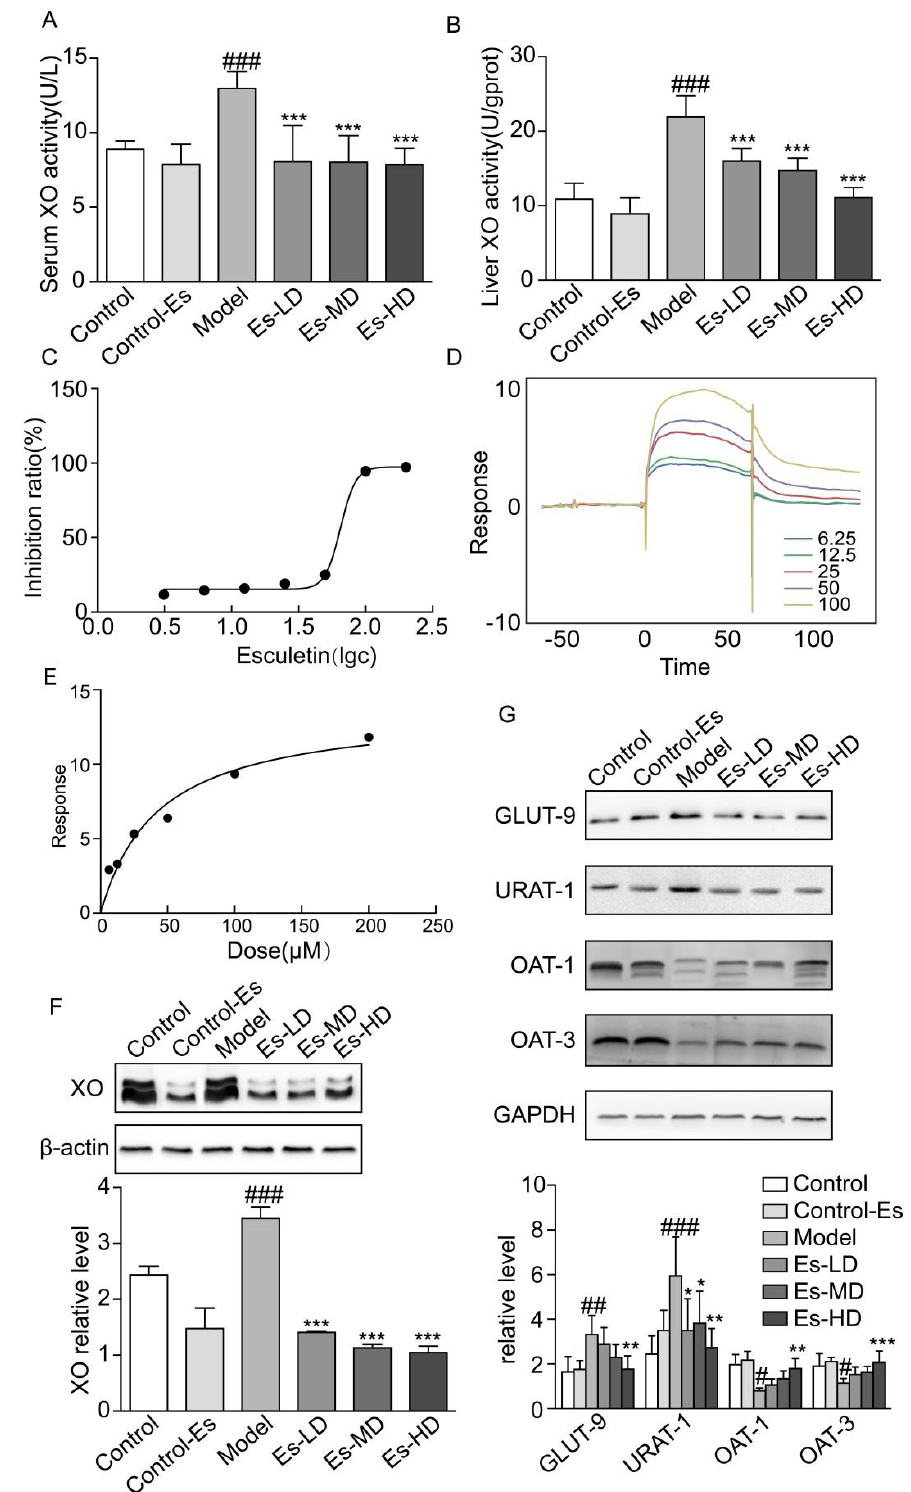
Figure 2. Esculetin reduces SUA levels. ( A ) Serum XO activity of HUA model mice, vertical bars show data with mean ± SD ( n = 6). ( B ) Liver XO activity. Vertical bars show data with mean ± SD ( n = 6). ### p < 0.001 vs. Control. *** p < 0.001 vs. Model. ( C ) Inhibition rates of esculetin on XO in vitro, IC 50 = 64.93 μM. ( D ) SPR dynamics of esculetin and XO. ( E ) SPR steady-state results of esculetin and XO. ( F ) Expression of XO in the livers of HUA model mice assessed through western blot analysis. ( G ) Uric acid transporter expression in the kidneys of HUA model mice. Vertical bars show data with mean ± SD ( n = 5). # p < 0.05, ## p < 0.01 ### p < 0.001 vs. Control. * p < 0.05, ** p < 0.01 and *** p < 0.001 vs. Model.